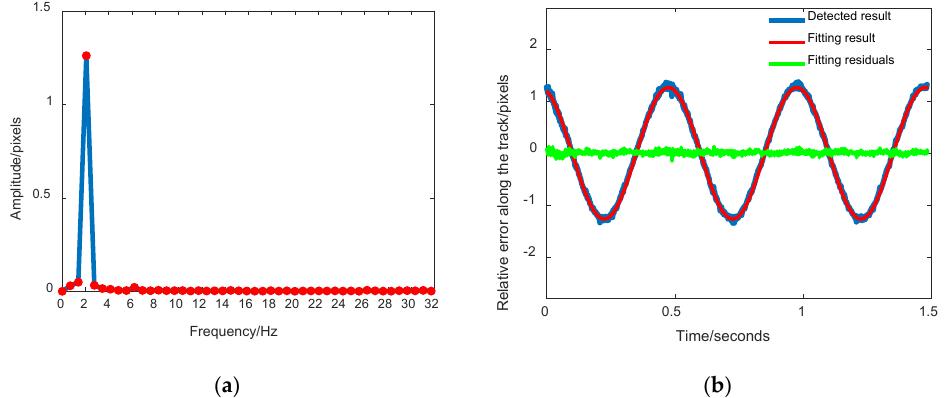
Figure 15. Analysis results of 10-Hz jitter detection curve after interpolation by sequential disparity maps. ( a ) Fourier analysis results; ( b ) Fitting results.